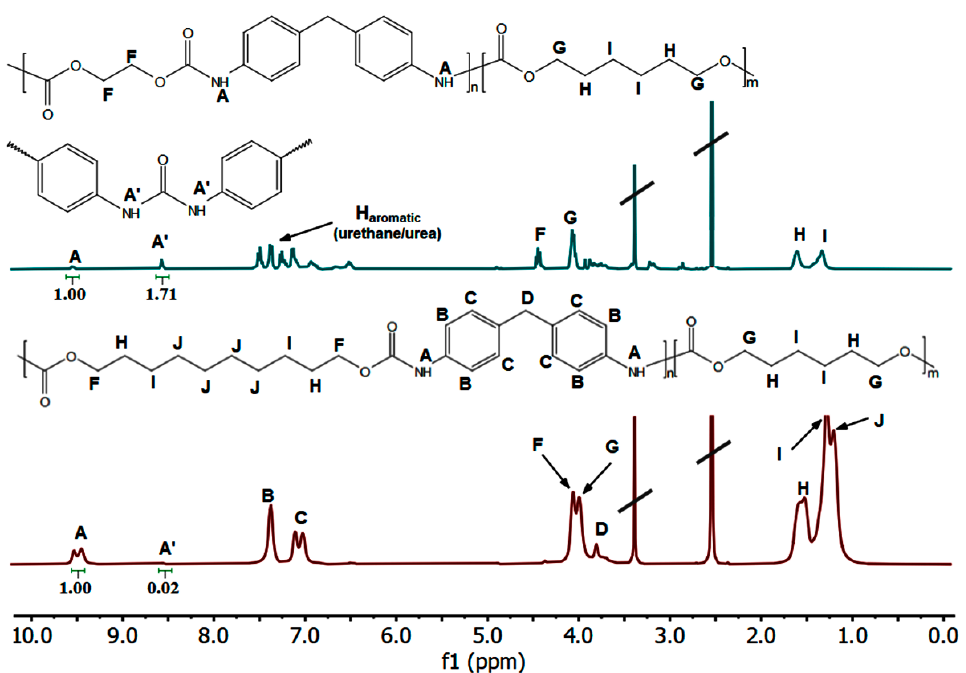
Figure 4. The comparison of the NIPCU_1_2 ( up ) and NIPCU_1_10 ( down ) structures based on 1 H NMR spectroscopy.